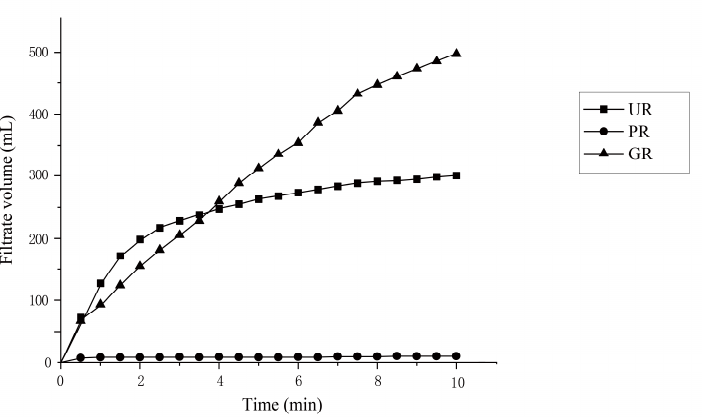
Figure 3. Filtering velocities of Monascus wines produced by three raw materials. Abbreviations: PR-polished rice, UR-unhusked rice, GR-germinated rice.